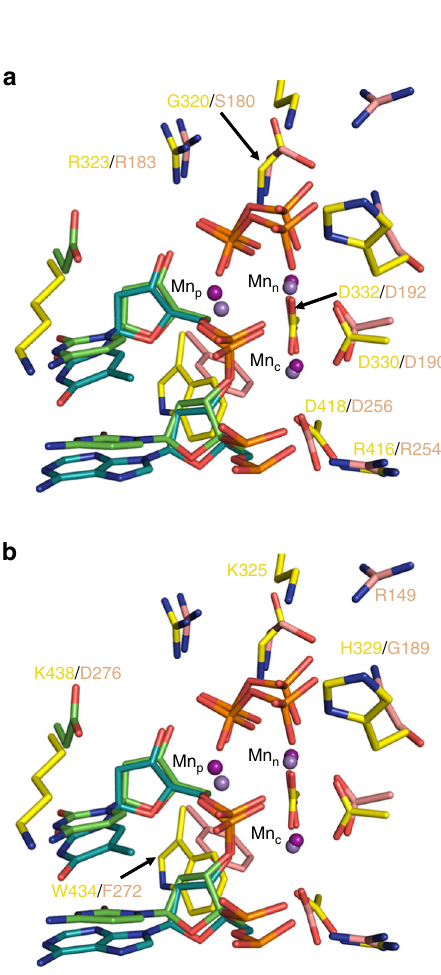
Fig. 8 Comparison of the active sites of the pol μ and β product complexes.